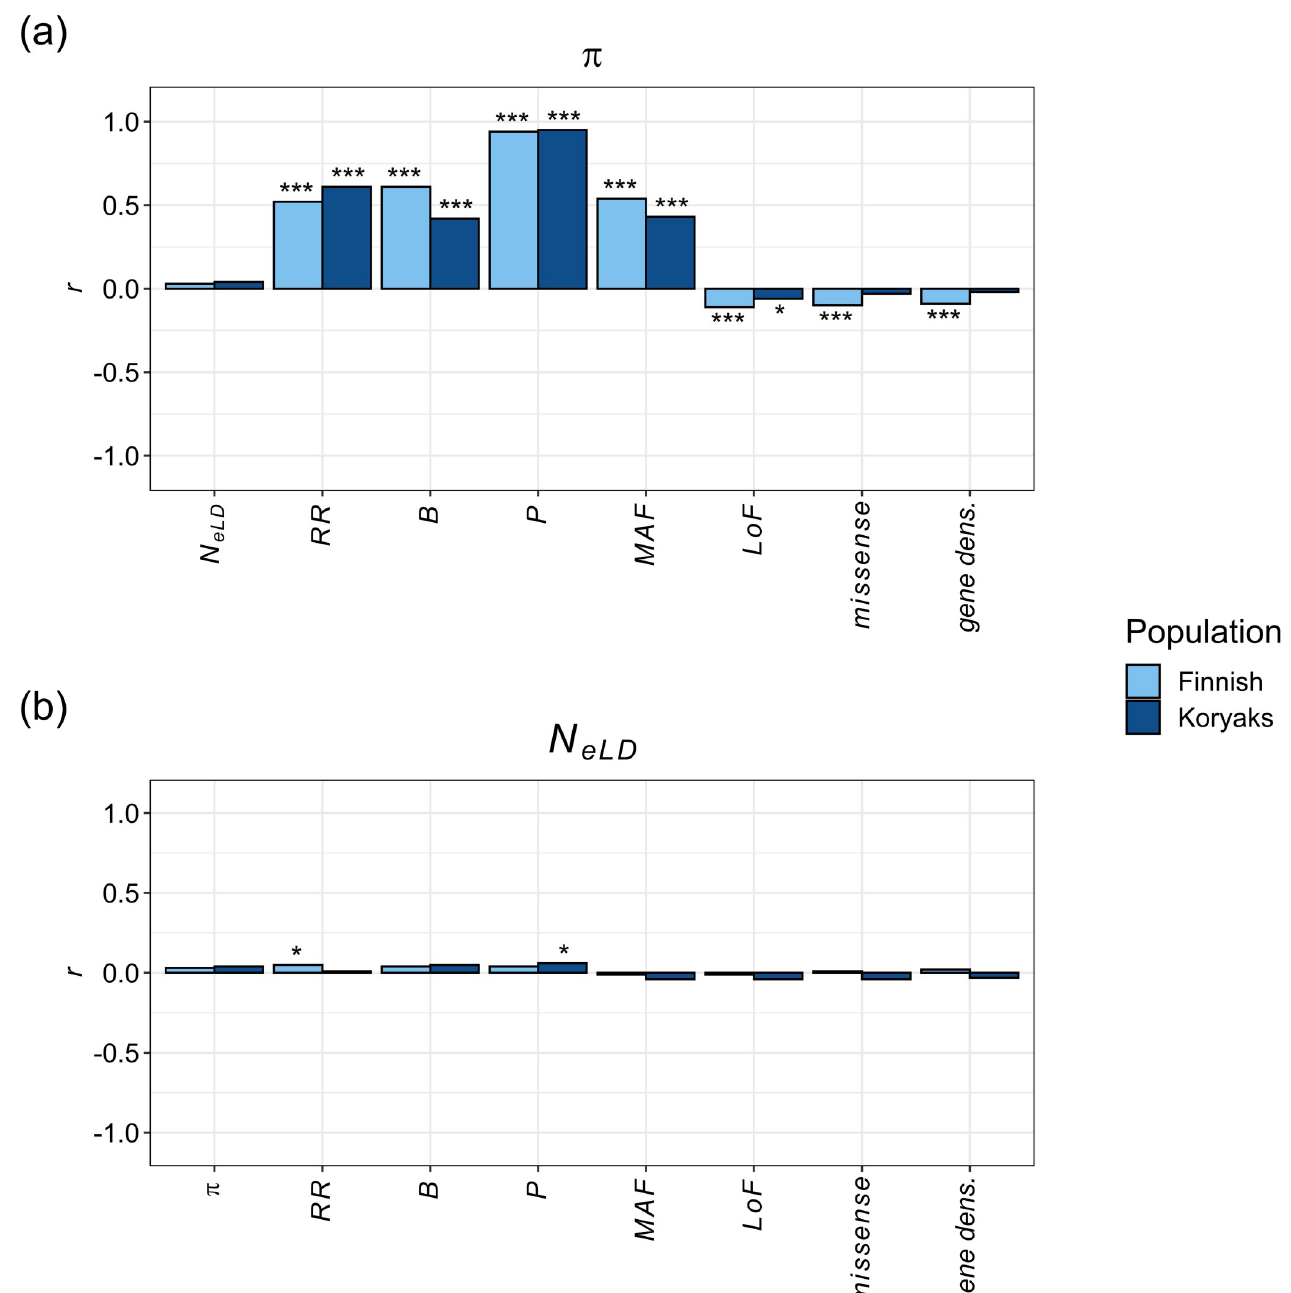
Fig 5. Spearman’s correlation coefficient ( r ) between nucleotide diversity ( π ; panel a) or estimates of linkage disequilibrium effective population size ( N ; panel b) and different diversity variables, estimated within genomic regions. RR : recombination rate; B : B statistic; P : proportion of polymorphic eLD nucleotides; MAF: Minor Allele Frequency; LoF : number of Loss of Function variants; missense : number of missense variants; gene dens : gene density. Estimates are based on samples of n = 99 for Finnish and n = 16 for Koryaks populations. P-values: � < 0.05, ��� <